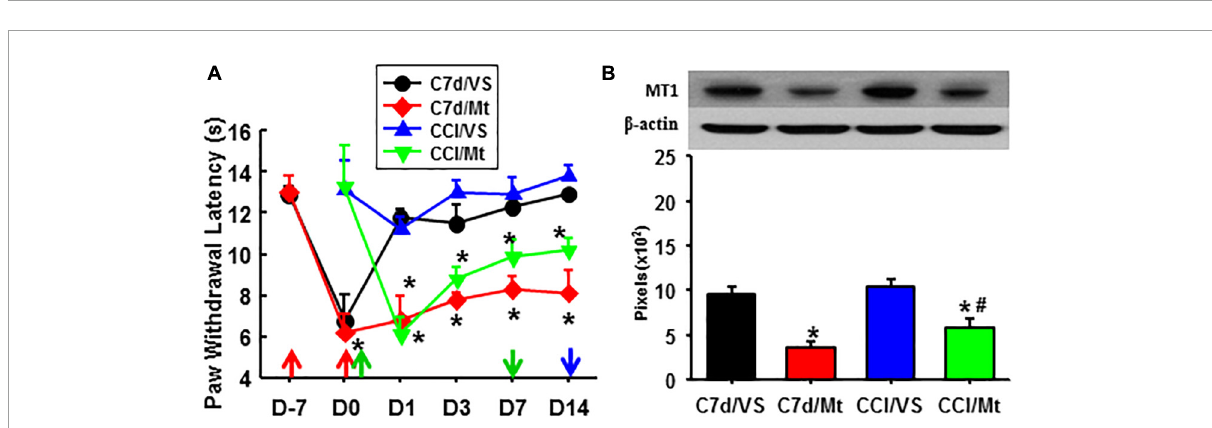
FIGURE4 Comparison of the effects between taVNS and exogenous melatonin. (A) A hyperalgesia threshold to thermal stimulation. * P < 0.05 vs. CCI/VS at the same testing time points. (B) Expression of MT1 in the amygdala (Day 14). * P < 0.05 vs. C7d/VS, # P < 0.05 vs. CCI/VS. D, day; the red arrow, CCI operation; the green up arrow, treatments start; the green down arrow, treatments end; the blue arrow, sacrifice; C7d/VS, C7d/Mt, CCI operation followed by taVNS or melatonin i.p. injection 7 days later, respectively; CCI/VS, CCI/Mt, CCI operation followed by taVNS or melatonin i.p. injection